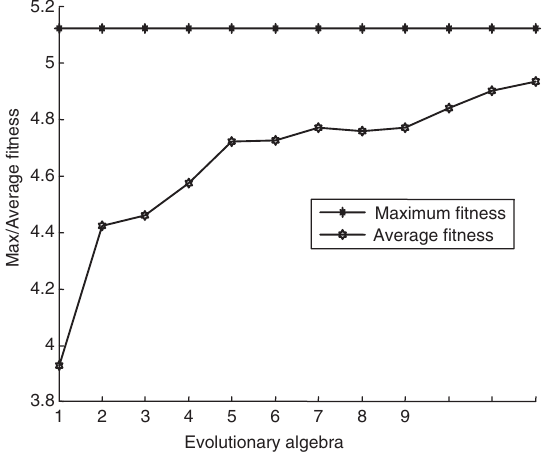
Figure 4: 2016 Smoothing Factor of Railway: Freight Incremental Fitness Curve Prediction.